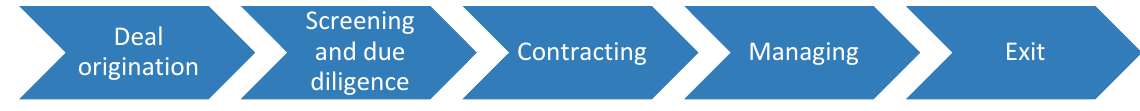
Fig. 1. The investment process of professional